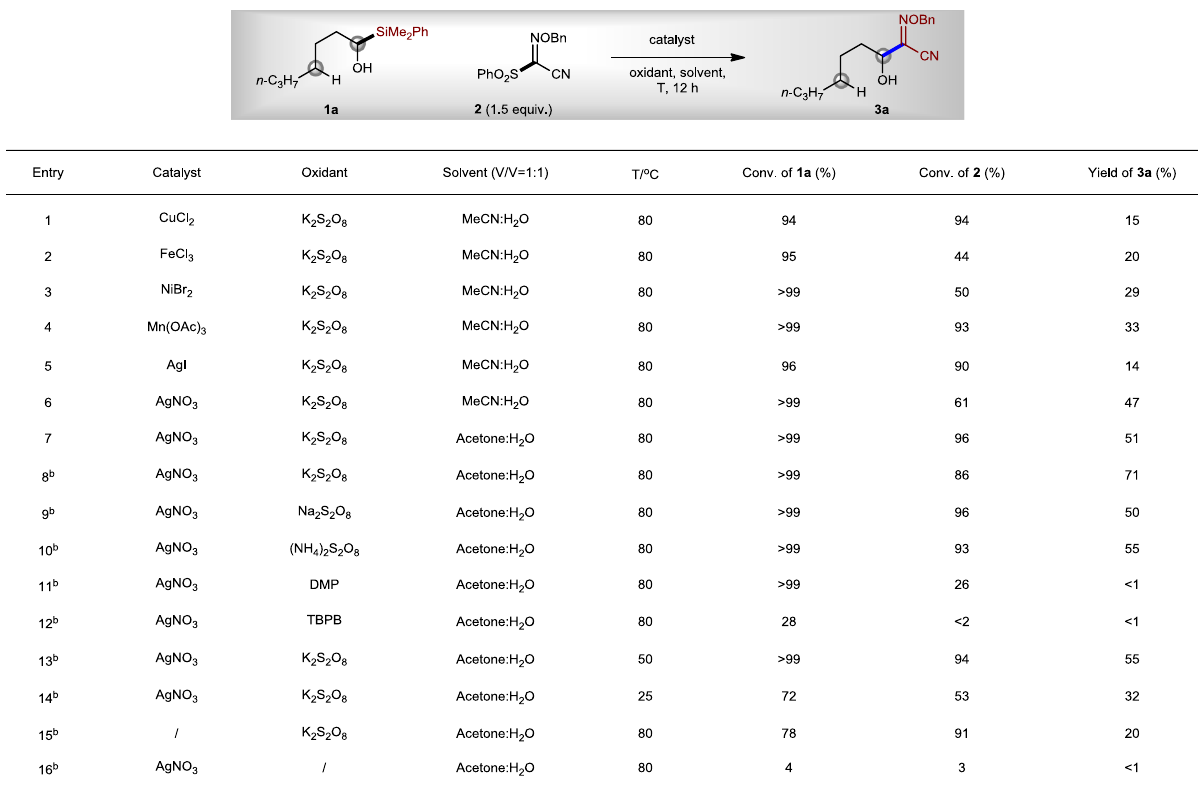
Fig. 2 Reaction optimization. a The mixture of 1a (0.2 mmol), catalyst (0.04 mmol), oxidant (0.4 mmol), and 2 (0.3 mmol) in the solvent (2 mL) was stirred at T under N 2 for 12 h. Conversions of 1a and 2 and yield of 3a were determined by 1 H NMR using BrCH 2 CH 2 Br as an internal standard. b Solvent (1.5 mL). DMP Dess – Martin periodinane, TBPB tert -butyl peroxybenzoate.